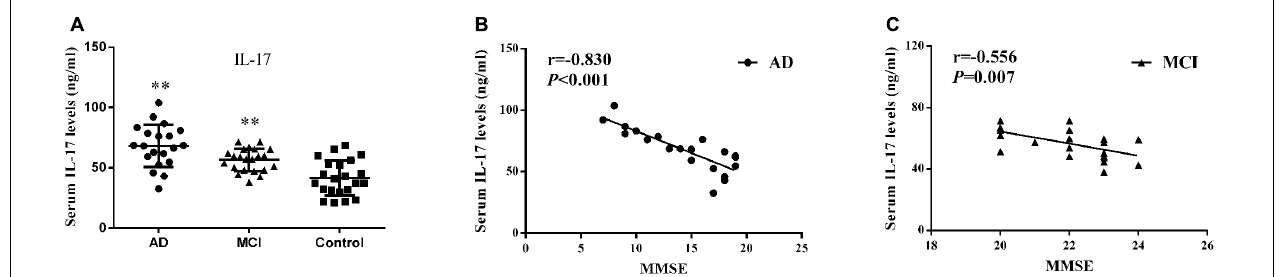
FIGURE 2 | Serum IL-17. (A) Concentrations of IL-17 in AD patients, MCI patients and controls. Bar graphs represent the mean ± SD, ∗∗ P ≤ 0.01 versus controls. Correlations between serum IL-17 levels and the MMSE scores in (B) AD and (C) MCI patients.